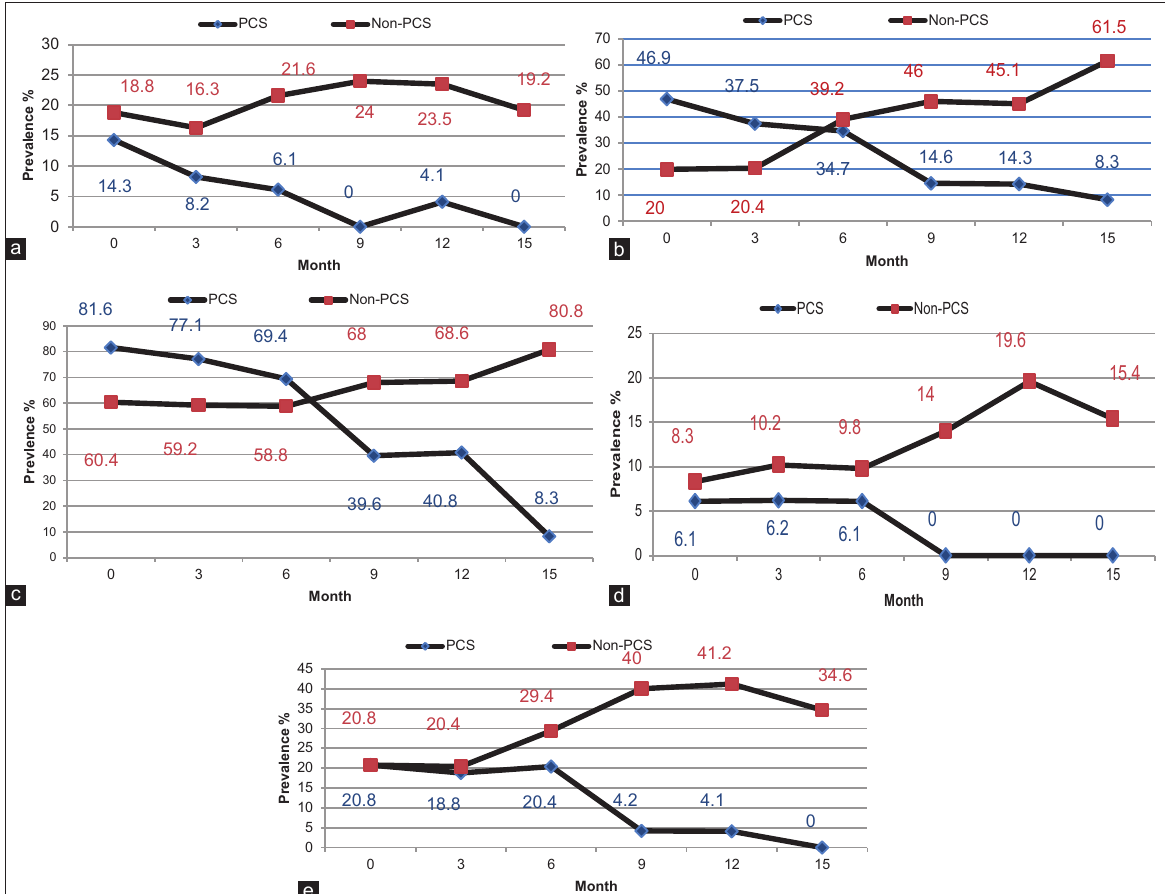
Figure-1: Prevalence of 5 parasite infections in confinement and non-confinement pigs during the monitoring period (0-15 months): (a) Ascaris suum ; (b) Trichuris suis ; (c) Strongyle type helminths ; (d) Physocephalus spp.; (e) Metastrongylus apri .